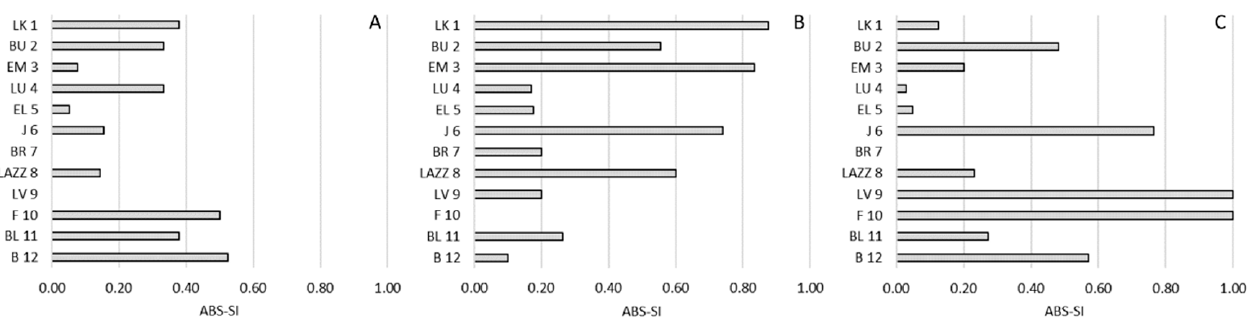
Figure 6. Bias of transversality preference (TI) and social hierarchy in Barbary macaques . Individuals (y-axis) are presented according to their social rank from 1 (the most dominant macaque) to 12 (the most dominated macaque), based on the CBI. ( A ): approach; ( B ): proximity; ( C ): affiliative contacts.